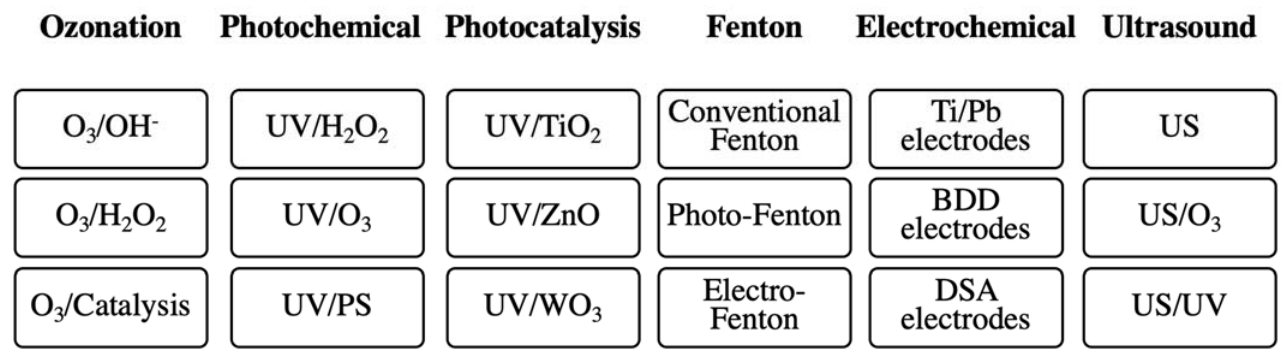
Figure 1. Advanced oxidation processes used in textile wastewater treatment.